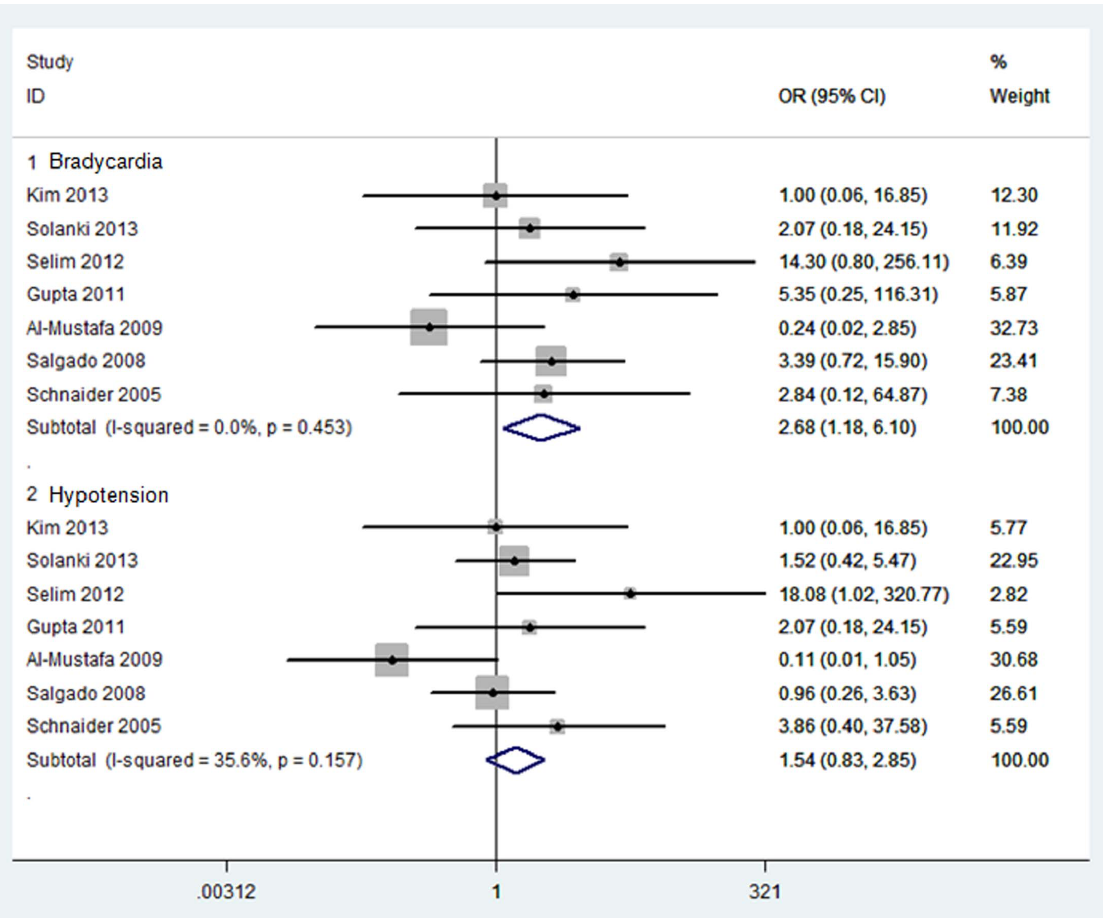
Figure 4. Forest plot: Primary adverse events: bradycardia and hypotension.